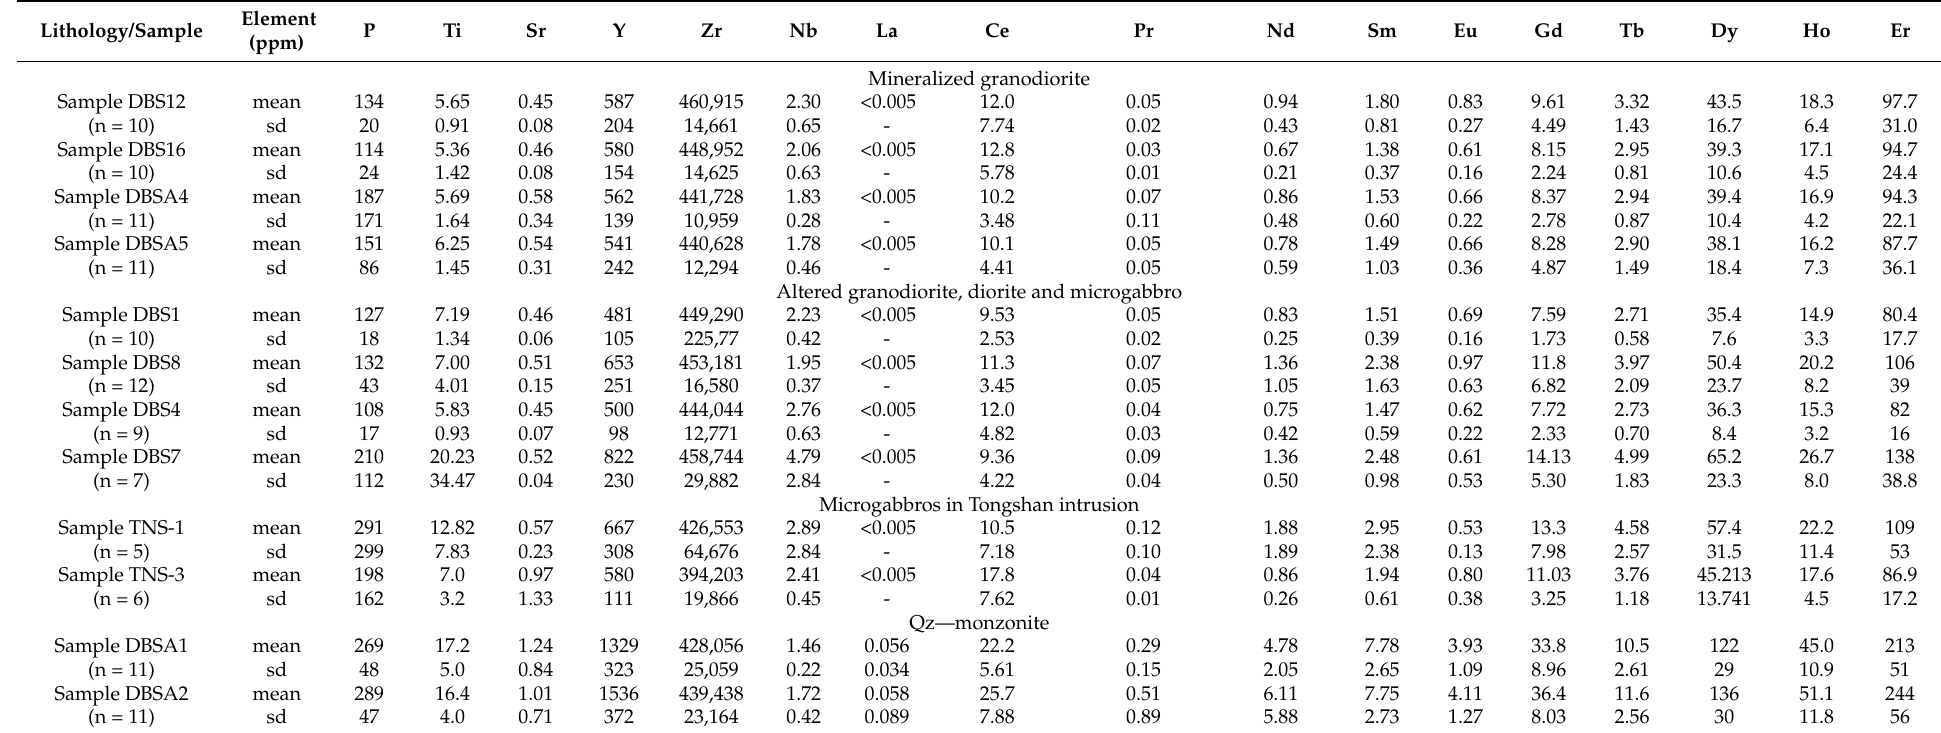
Table 1. Major and trace element contents of zircon in samples from the DBS-TS ore-bearing